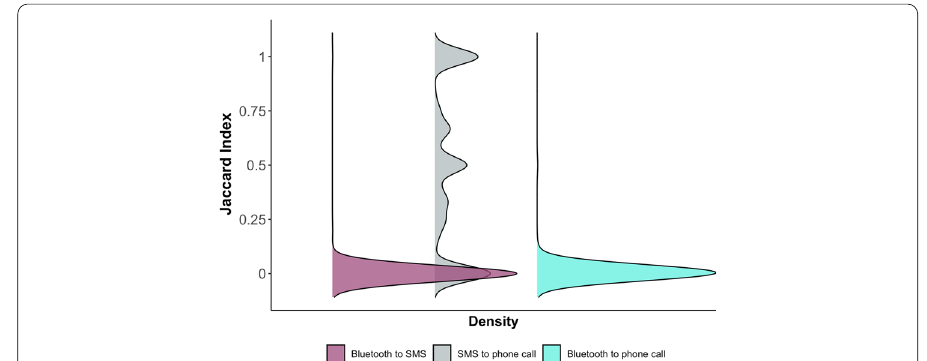
Fig. 5 The Jaccard Indexes are averaged over the participants for each pair of comparison among the three networks. The similarity of alter composition between the text message network and the phone call network is indicated by the higher Jaccard Index between SMS and phone